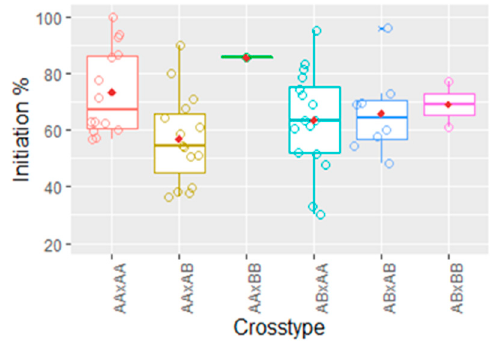
Figure 1. Mean SE-initiation % of different parent PaLAR3 genotypes from 2011 to 2015. Each circle denotes initiation % of one full-sib SE-family. denotes initiation % of one full-sib SE-family.